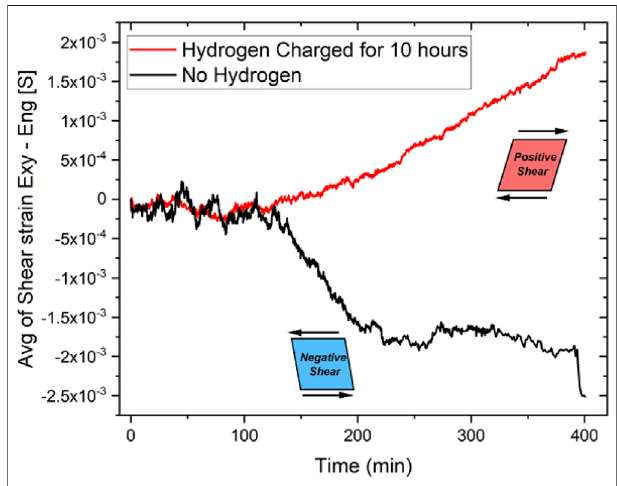
FIGURE 16 | Extracted average shear strains from the DIC strain analysis.